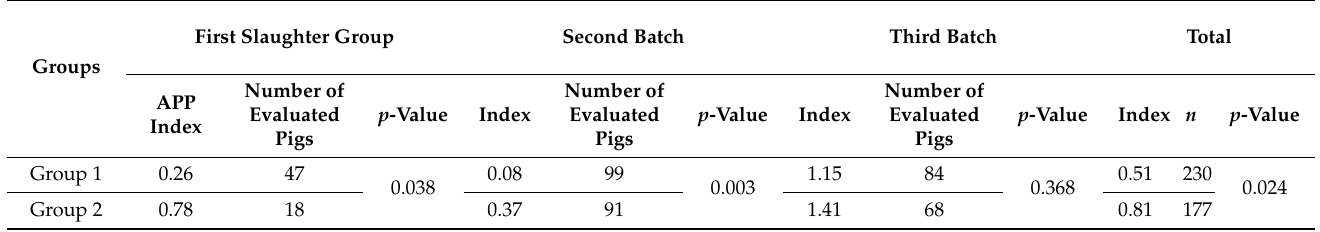
Table 2. Lung lesion scoring for the different study groups at the different points of time of lung scoring at the slaughterhouse.